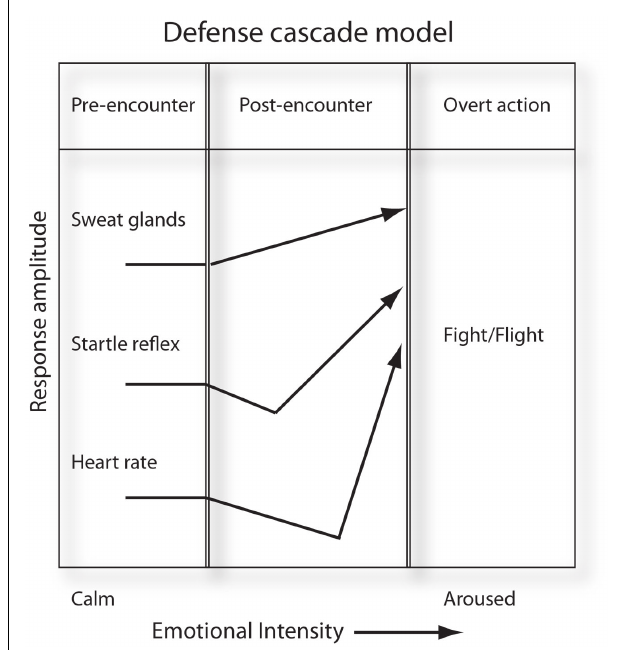
FIGURE 1 |Action as a function of action tendency variables – the defense cascade model. The relationship between bodily variable activity (arousal-relevant) antecedent to action is non-monotonic.The action tendency therefore is dynamic and changes as a function of time and/or perception of the emotion eliciting stimulus. Adapted from Bradley and Lang